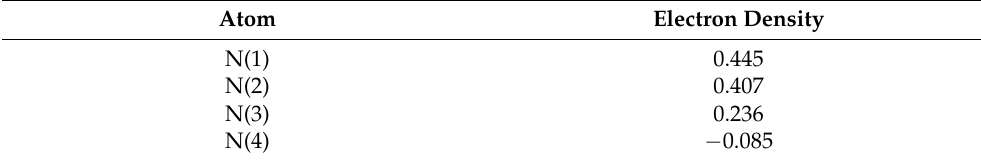
Table 7. Electron densities on the selected atoms of [Cell-O(6)-IME] + Cl − . Atom